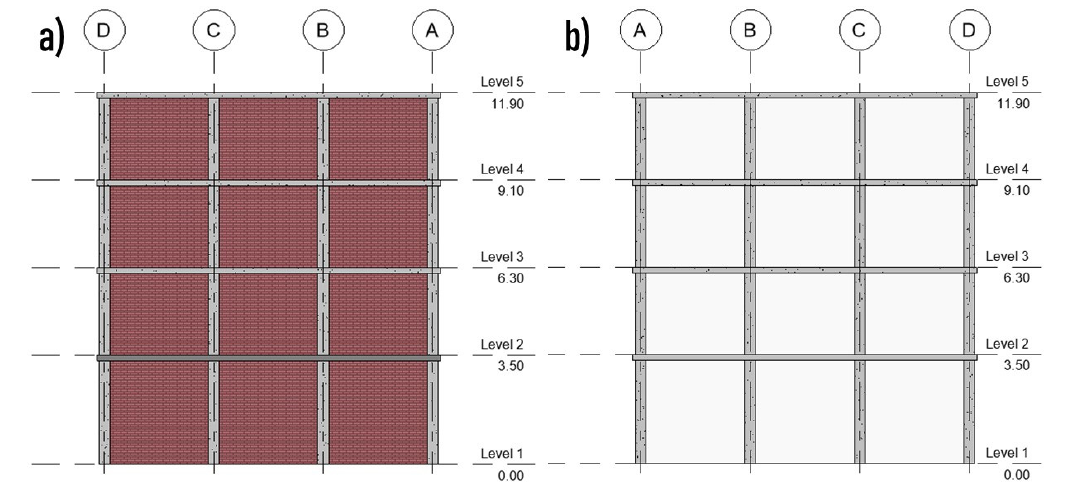
Figure 5. Elevation views: ( a ) west and ( b ) east.